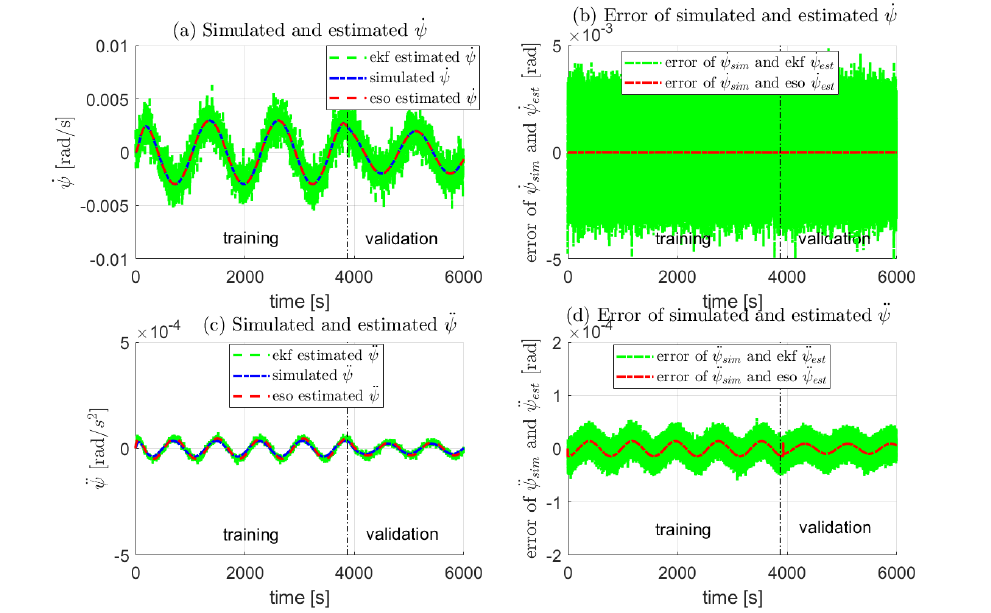
Figure 5. Estimated states of the cargo vessel. The data on the left side of the black dotted line are training samples and on the right side are validation samples.